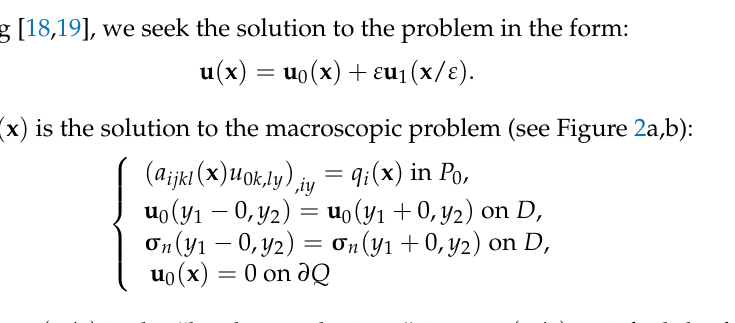
Figure 6. The von Mises stress concentration in the vicinity of symmetric weld: ( a ) tension along Ox -axis, ( b ) tension along Oy -axis, ( c ) shift.